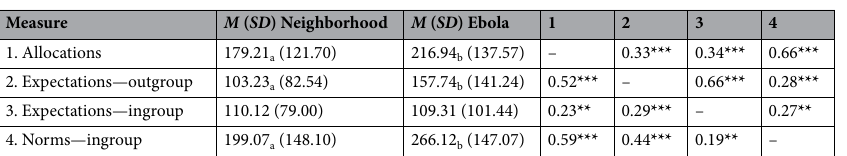
Table 4. Means (M), standard deviations (SD) and correlations between participants’ own allocations to collective account, their expectations of others’ allocations to this account, and prescriptive norms in Study 3 (numbers above the diagonal represent correlations in the neighborhood context, numbers below the diagonal represent correlations in the Ebola context). *** p < 0.001. Means within rows not sharing a common subscript differ significantly ( p <